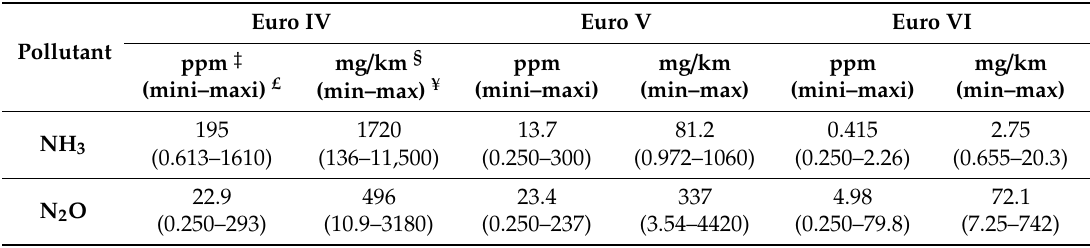
Table 5. NH 3 and N 2 O mean, minimum, and maximum exhaust contents (ppm) and